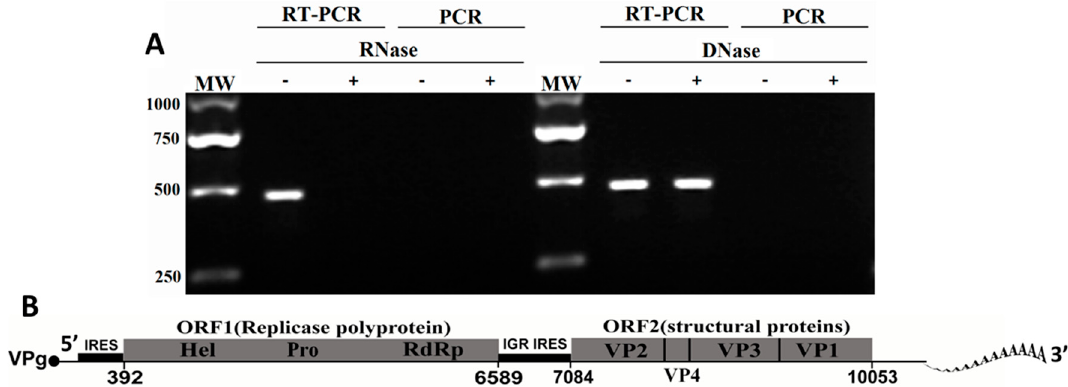
Figure 3. Characterization of the MrTV. ( A ) Sensitivity of MrTV RNA to single strand-specific RNase